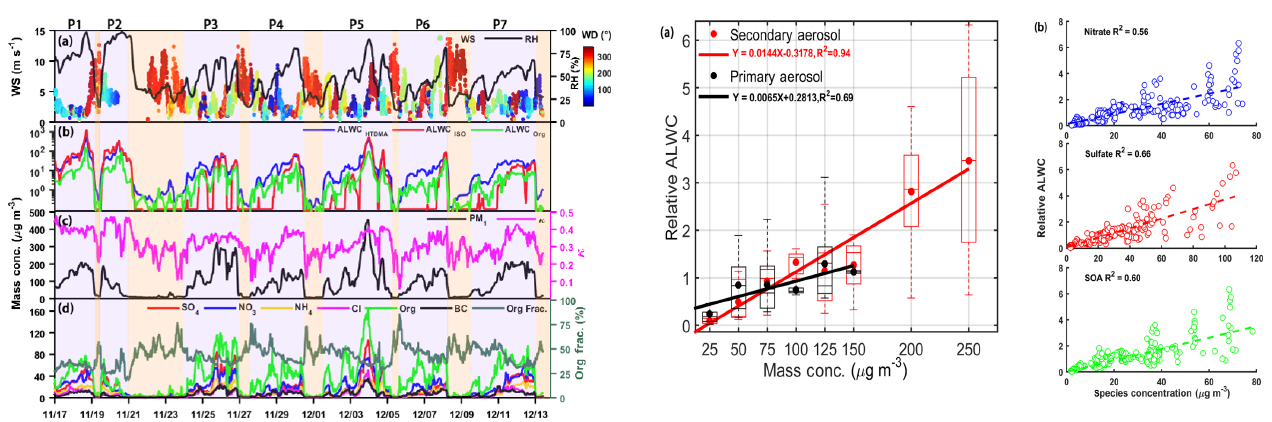
Figure 3. The correlation analysis between relative ALWC and (a) primary (in black) and secondary (in red) aerosol mass concen- trations and (b) nitrate, sulfate and secondary organic aerosol (SOA) mass concentrations. Shown in (a) are mean relative ALWCs (solid dots) with boxes showing the 25th, 50th and 75th percentiles. The extremities show the 5th and 95th percentiles. The solid lines in (a) and the dashed lines in (b) both represent the corresponding best-fit lines from linear